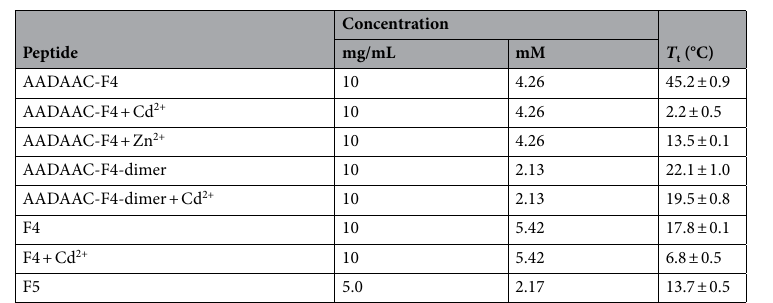
Table 2. The phase transition temperature ( T t ) values of the synthesized peptide analogues. Mean T t values with SE were shown in the table. Each peptide was dissolved in Tris–HCl buffer solution (50.0 mM